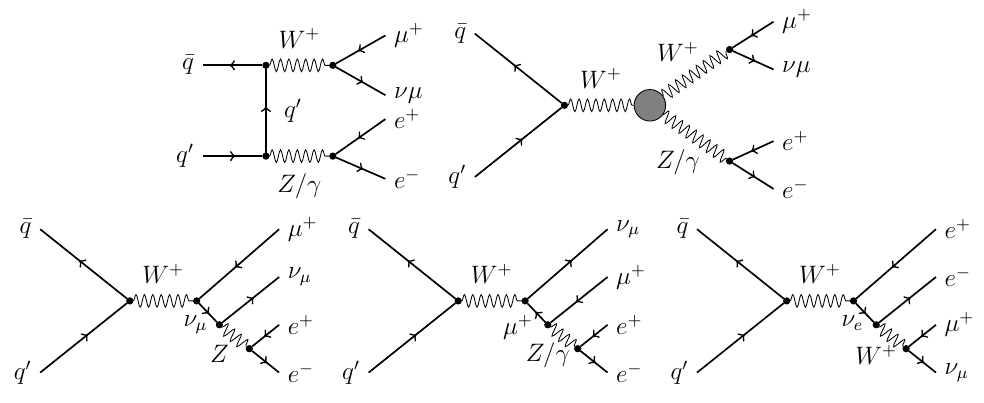
1 Figure 1 . Sample of Born level Feynman diagrams for ZW + production in the e + e (cid:0) (cid:22) + (cid:23) (cid:22) channel at the LHC. The diagrams for ZW (cid:0) can be obtained by charge conjugation. The shaded blob represents the presence of anomalous WWV couplings on top of SM.